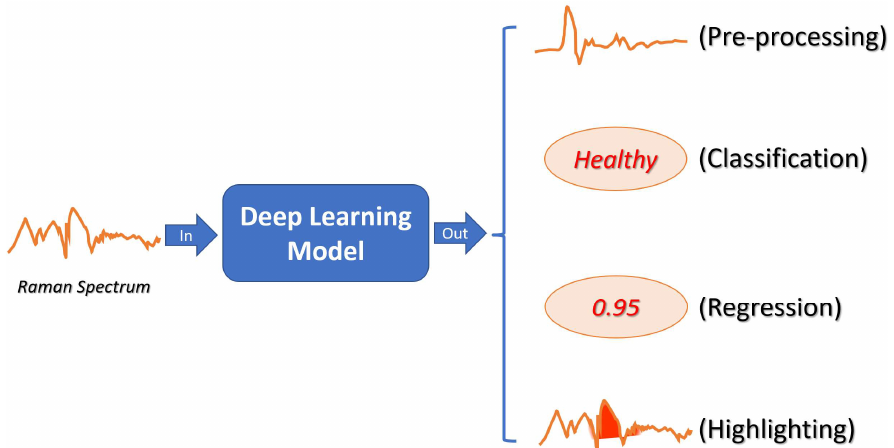
Figure 8. Four types of deep learning applications for Raman spectroscopy. Based on outputs, there are four types of models: pre-processing, classification, regression, and highlighting. In a pre-processing model, the output is another Raman spectrum; in a classification model, the output is a label (e.g., “healthy”); in a regression model, the output is a number or probabilistic value (e.g., “0.95”); in a highlighting model, the output is a certain spectral region of interest (ROI) of the input spectrum.